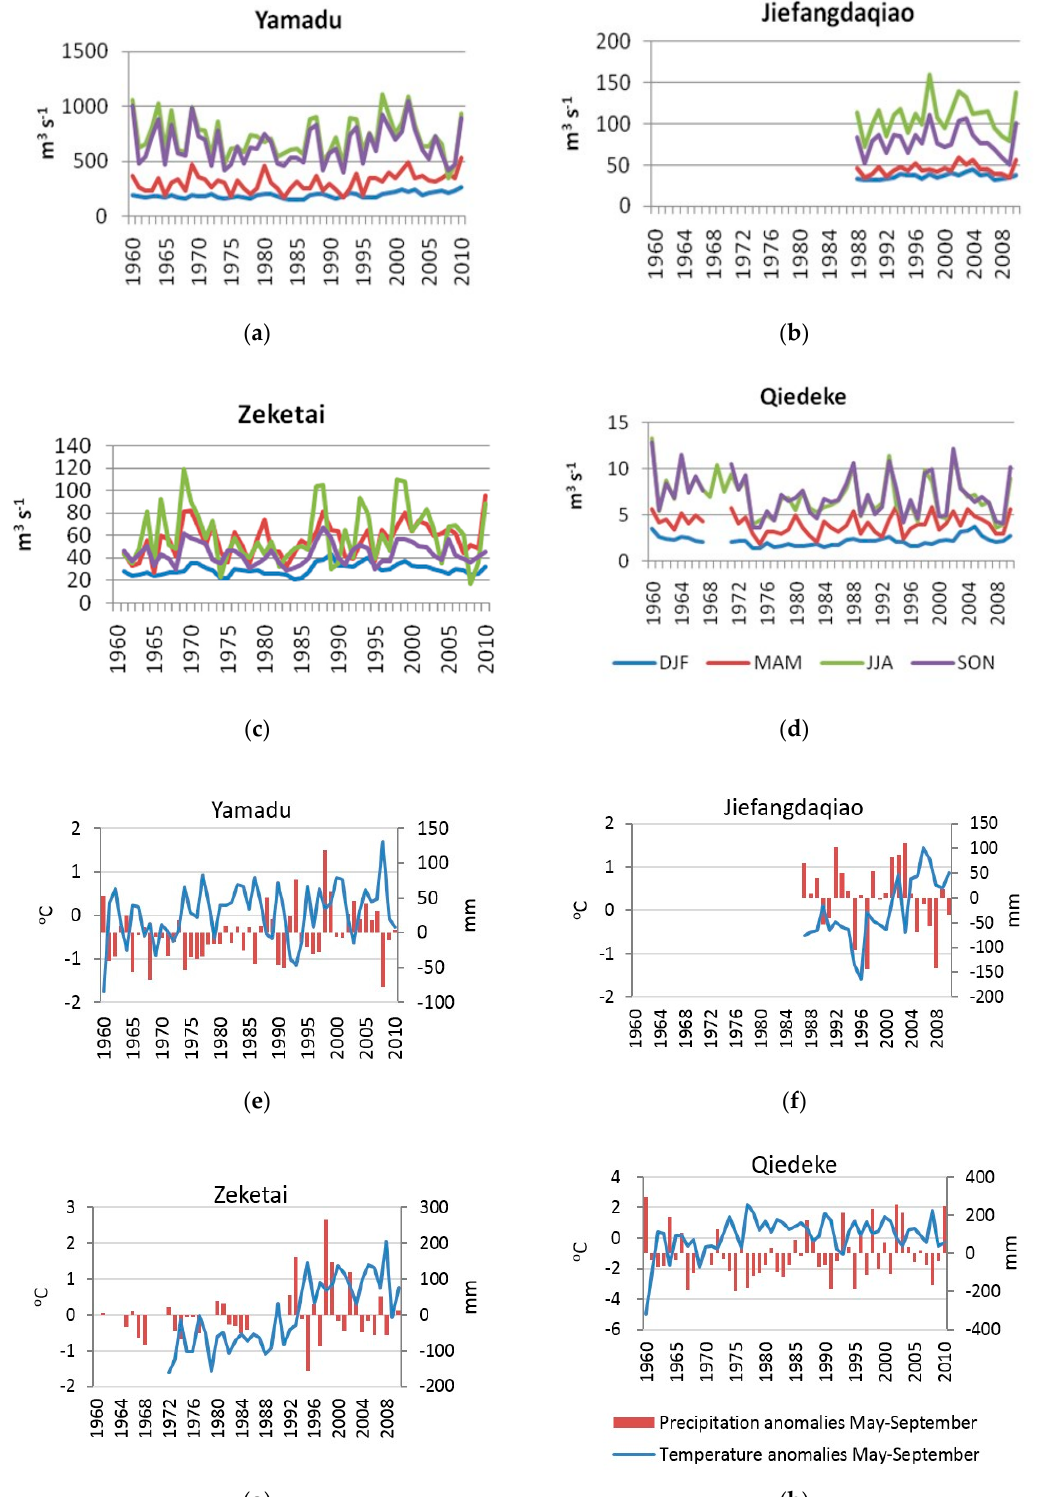
Figure 9. Time series of seasonal mean streamflow (m 3 s − 1 ) ( a – d ) and precipitation and temperature anomalies during the warm season (May to September) ( e – h ). Note that different scales are used for different rivers.